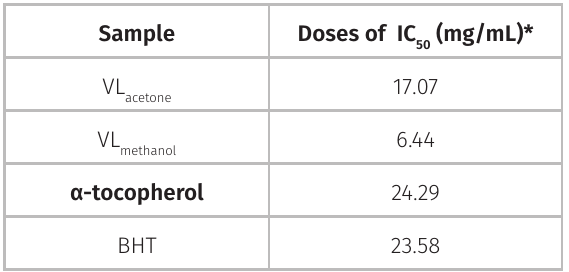
values of BHT, α-tocopherol 50 , VL extracts against the acetone methanol